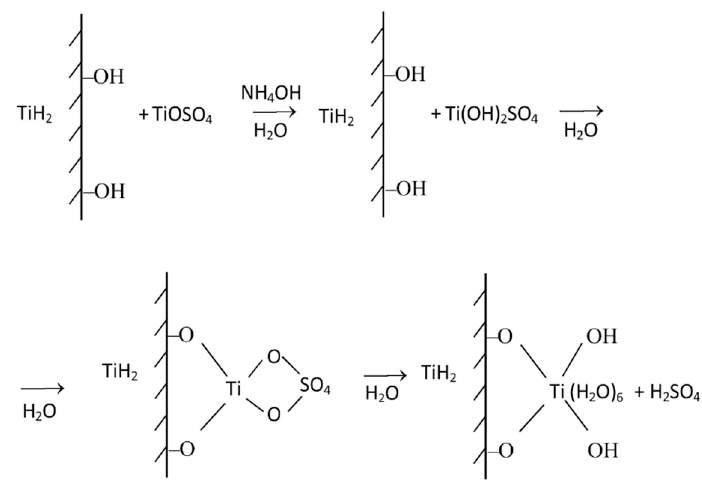
Figure 9. Mechanism of interaction of titanium sulfuric acid salts with the shot surface.